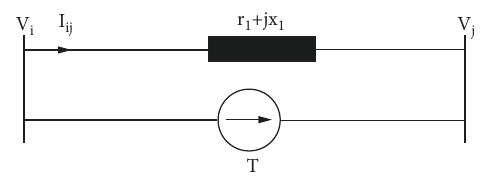
Figure 7: Replacement of voltage source with fow source.